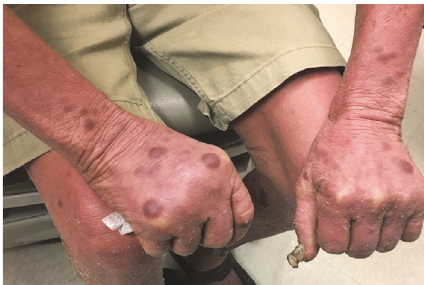
Figure 1: Scattered violaceus nodules, and plaques, some with serous exudate located on the dorsum of the hands.